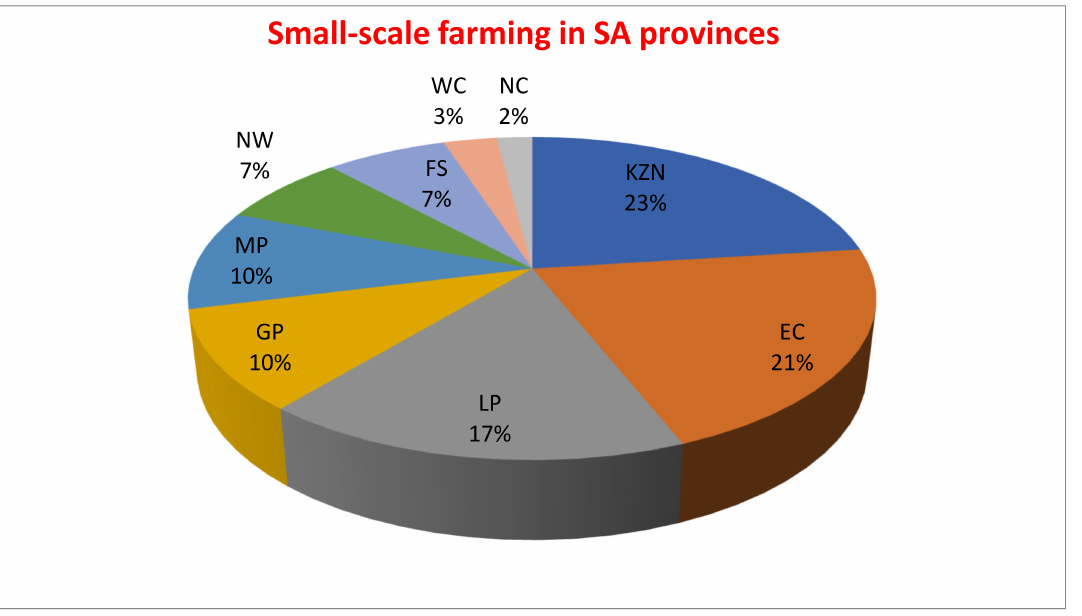
Figure 1. Small-scale farming at provincial levels in SA. Key: NW = North West,